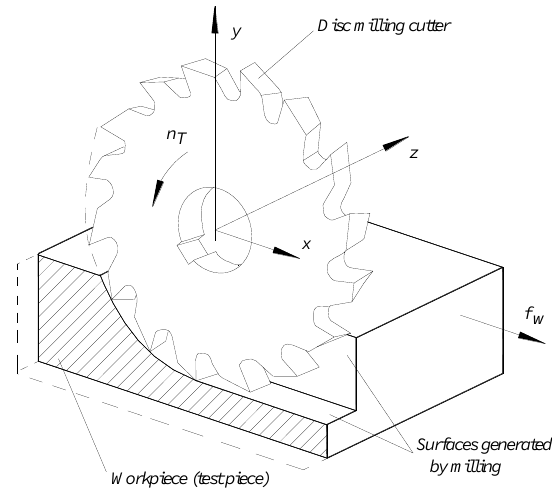
Figure 2. Cutting scheme when milling with a disc cutter.